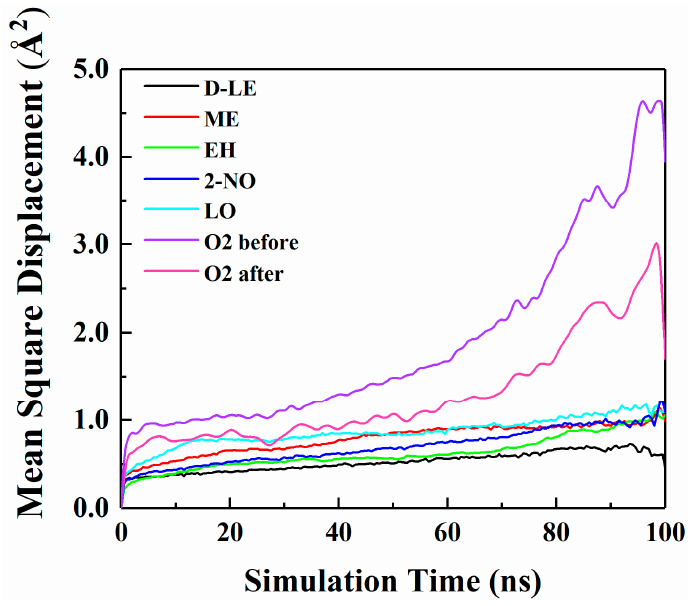
Figure 7. MSD curves of O 2 and five flavor organic molecules in PE. Materials 2019 , 12 , x FOR PEER REVIEW 12 of 16